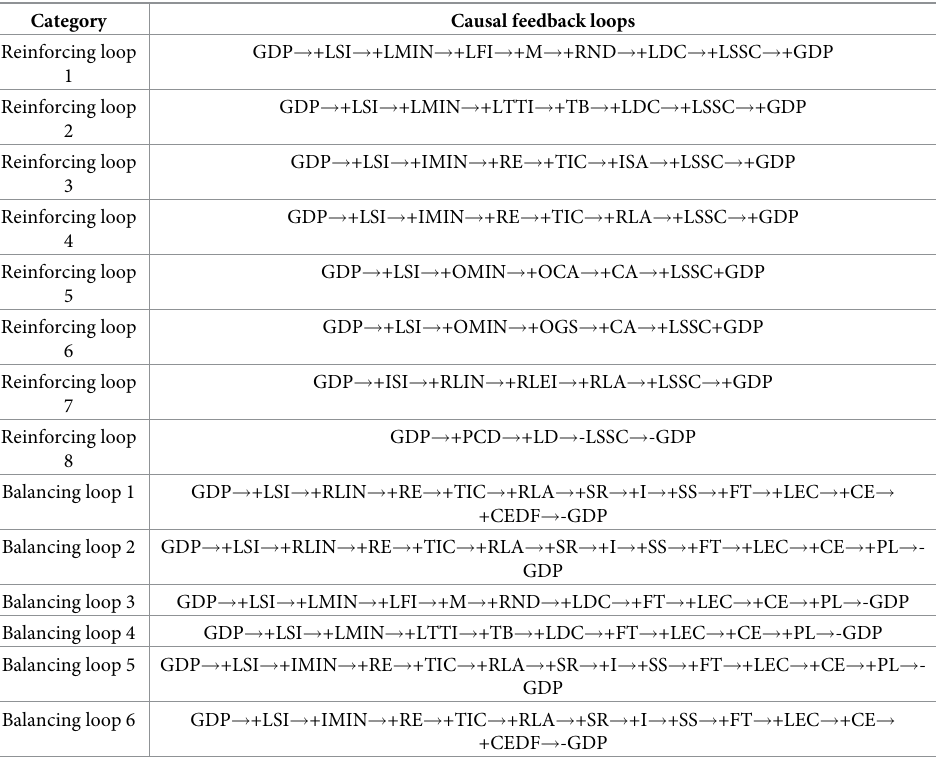
Table 3. Main feedback loops in the